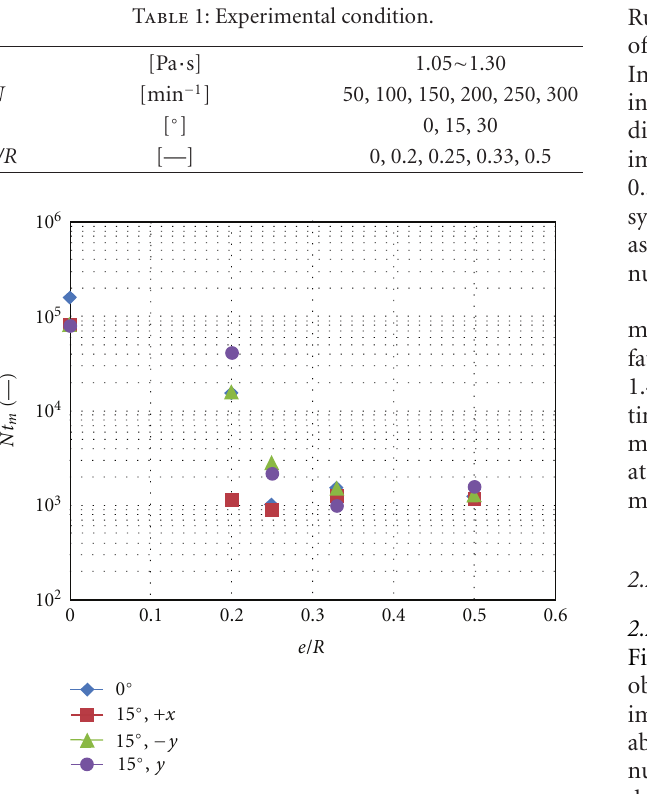
Figure 4: Relationship between dimensionless mixing time and eccentric